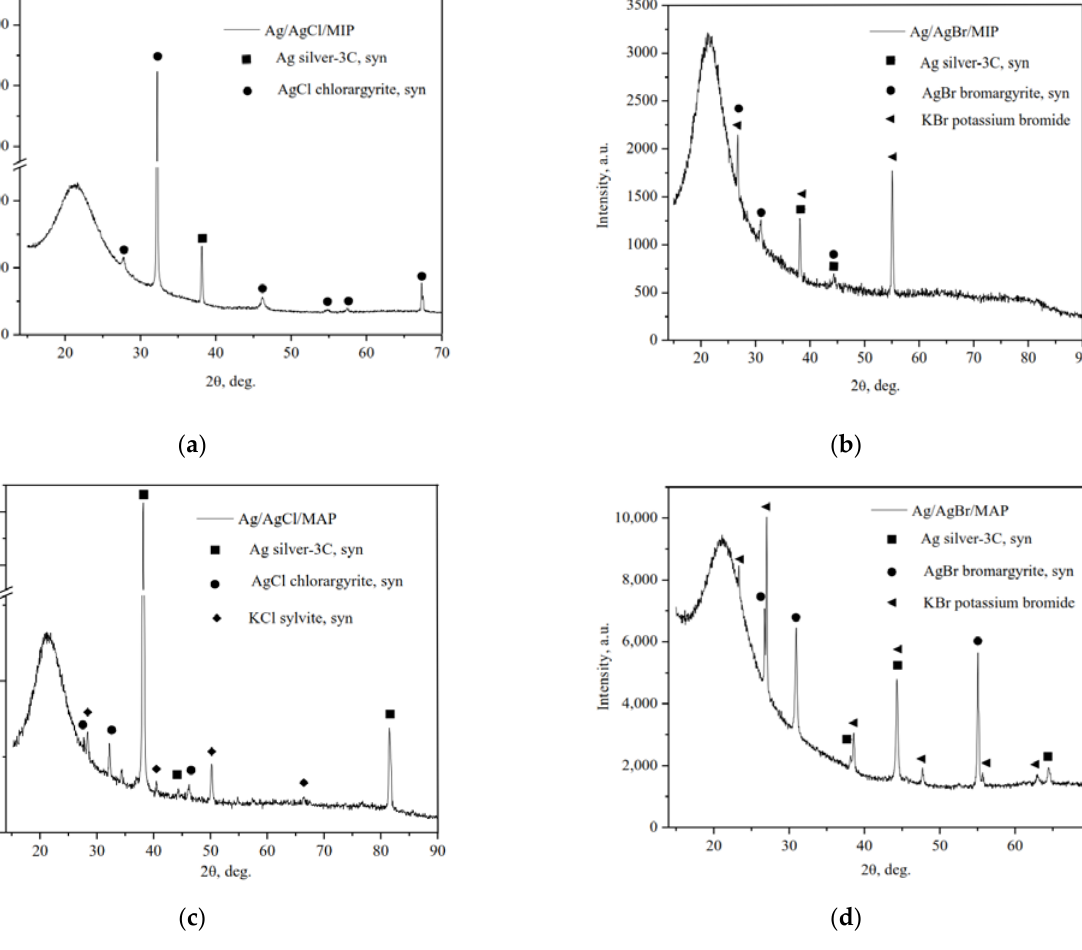
Figure 1. XRD patterns of the as-prepared Ag/AgHal-modified vitreous membranes: Ag/AgCl/MIP ( a ); Ag/AgBr/MIP ( b ); Ag/AgCl/MAP ( c ); Ag/AgBr/MAP ( d ).